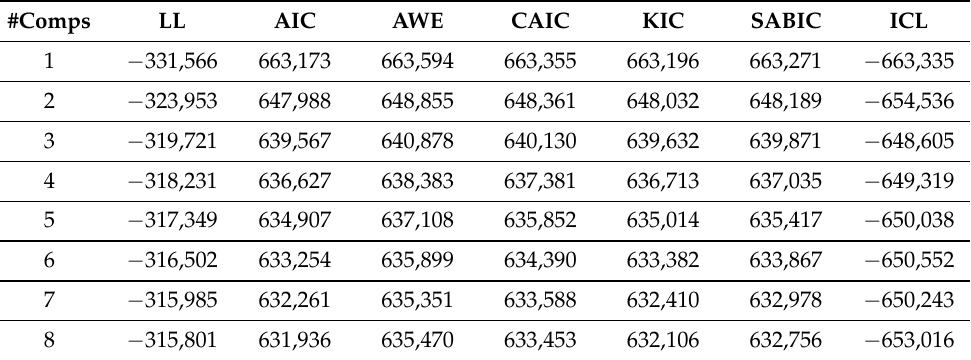
Table 1. Additional statistics Log-likelihood (LL), Aikake Information Criterion (AIC), Approximate Weight of Evidence (AWE) [41], Consistent Aikake Information Criterion (CAIC), Kullback Infor- mation Criterion (KIC) [42], Sample Size-adjusted Bayesian Information Criterion (SABIC) [43], and Integrated Completed Likelihood (ICL)